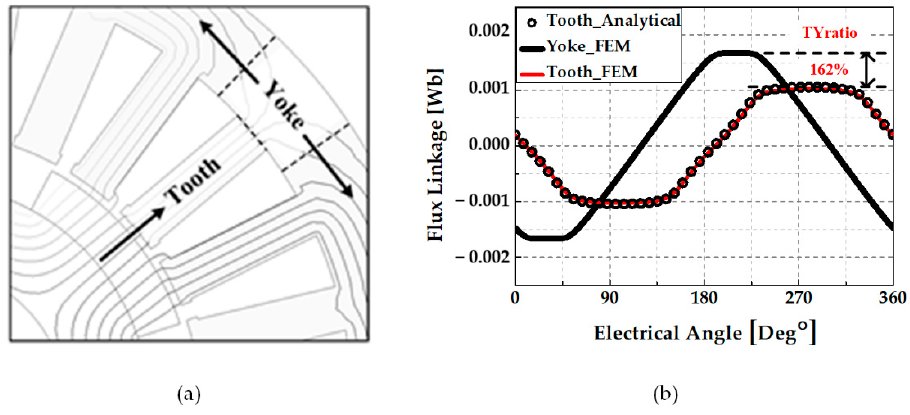
Figure 3. ( a ) Conceptual diagram of the magnetic flux flow, and ( b ) the tooth and yoke magnetic flux according to rotor position.